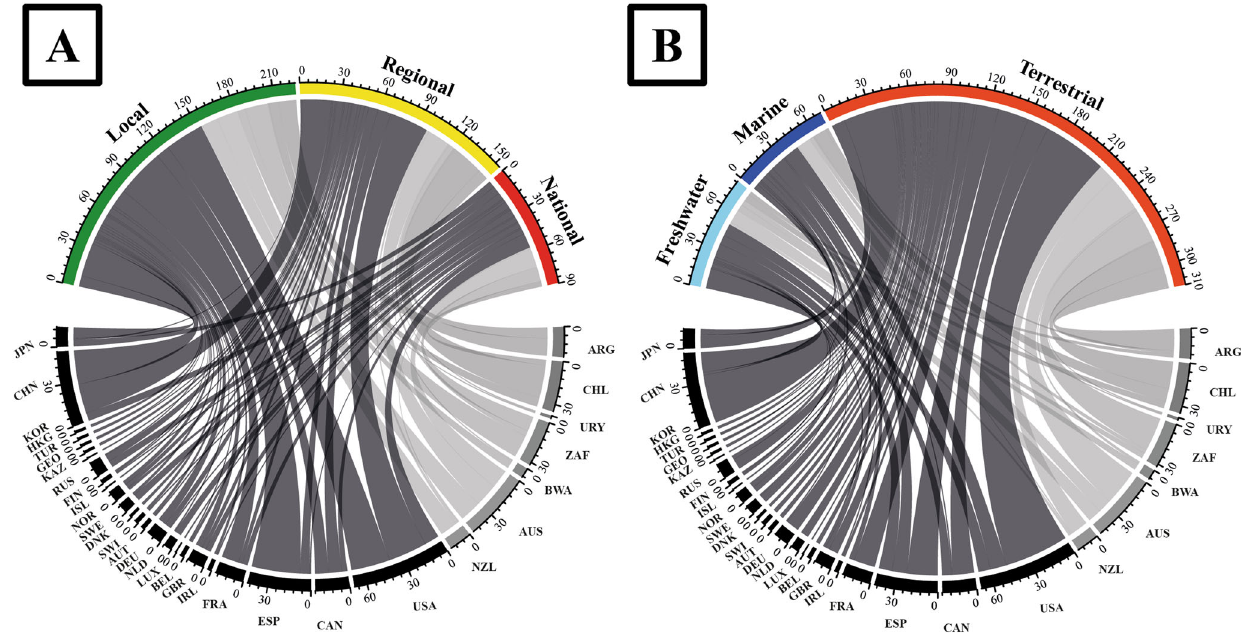
Fig. 5 Chord diagrams illustrating the spatial scale proportion and the different prominent natural systems. Spatial scales ( A ) and predominant natural systems ( B ) of the socio-ecological papers ( n = 467 papers) from 1992 to 2021 (see Annex 1 for countries